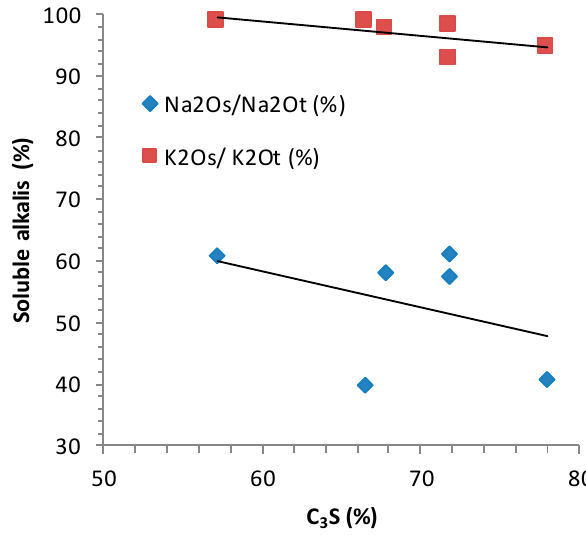
Figure 3. Soluble alkalis versus C 3 S percentage.